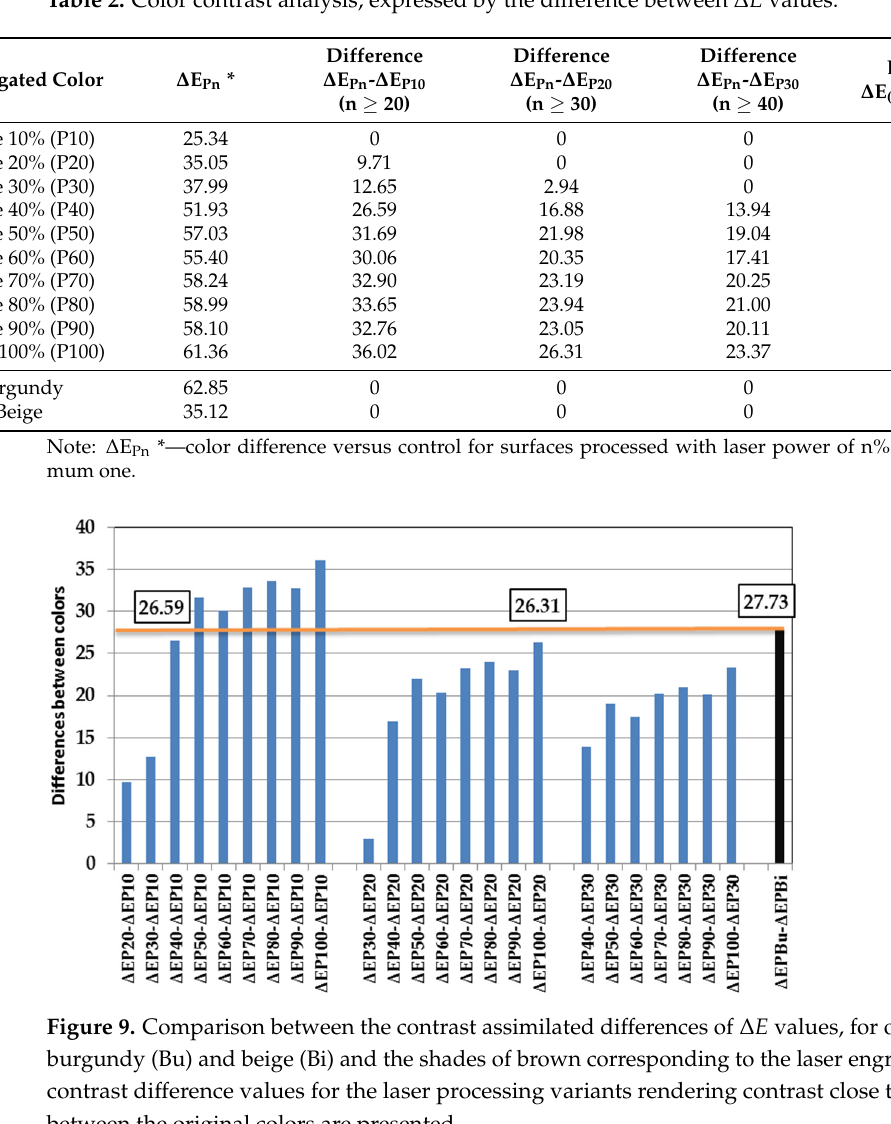
Table 2. Color contrast analysis, expressed by the difference between Δ E values.